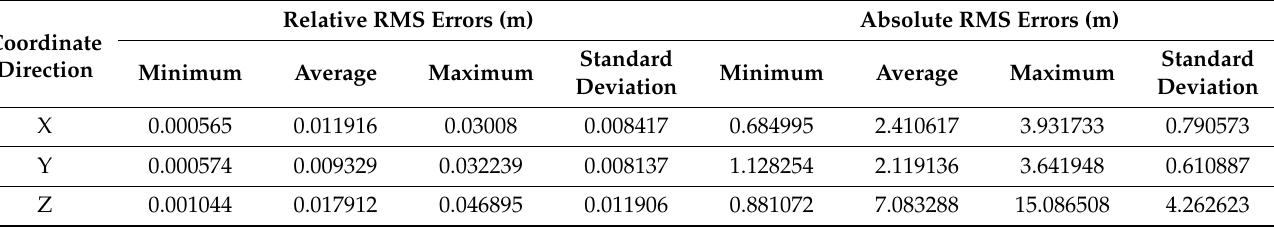
Table 2. RMS Error Values by Coordinate Direction.